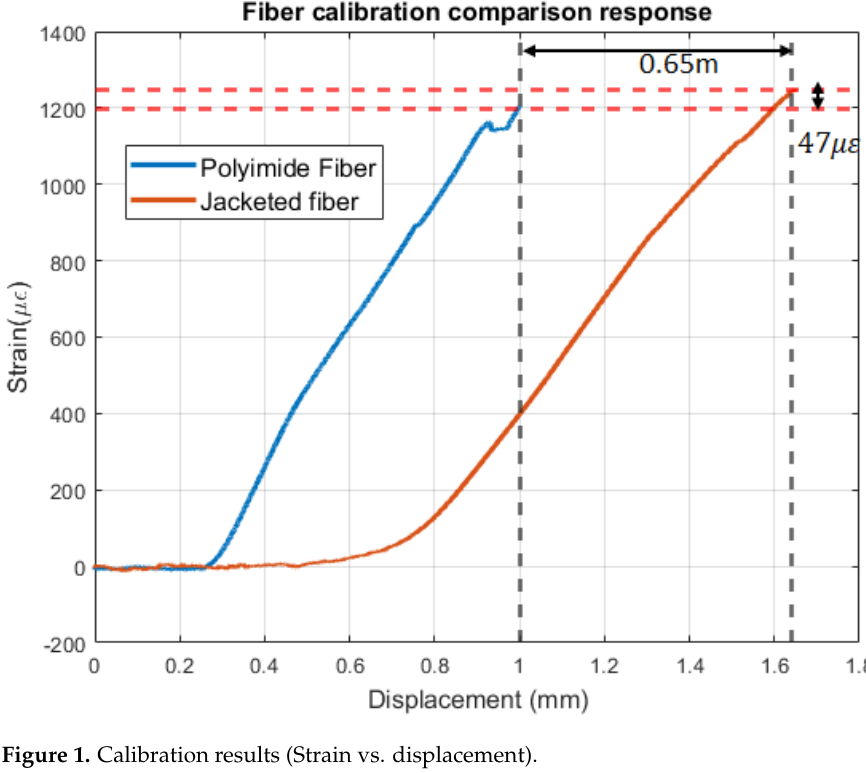
Figure 1. Calibration results (Strain vs. displacement).